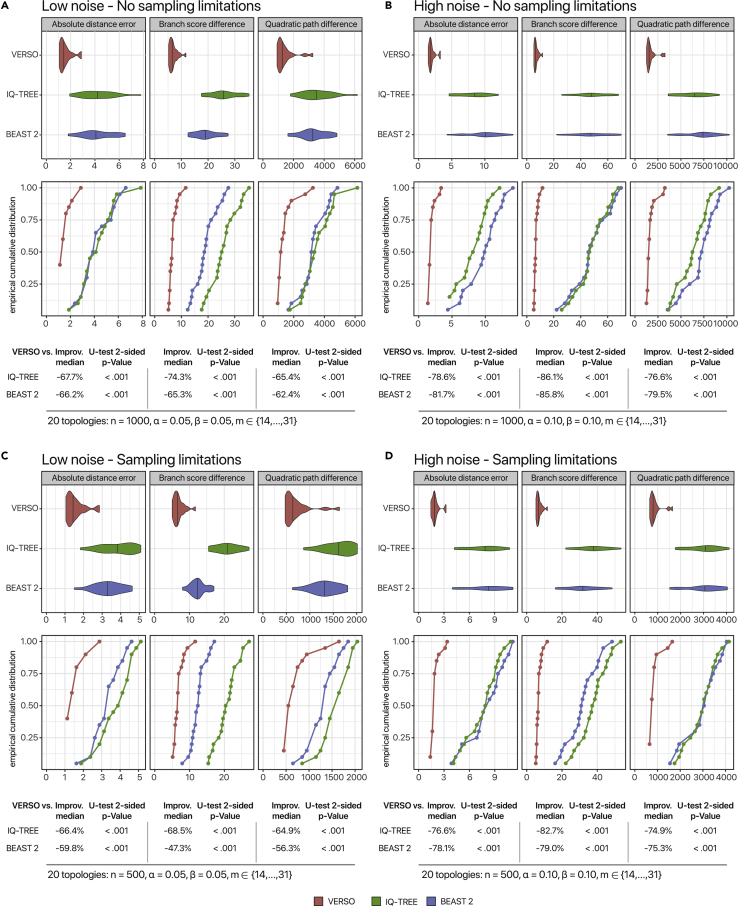
Comparative assessment on simulated data(A–D) Synthetic datasets were generated via the widely used coalescent model simulator msprime70 (see the Supplementary Material and Table S1 for the parameter settings). Twenty distinct topologies with 1,000 samples were generated, including a number of distinguishable variants in the range (14, 31). For each topology, four synthetic datasets were generated, with different sample sizes (n = 1000, 500), and different combinations of false-positives and false-negatives ([α = 0.05, β = 0.05], [α = 0.10, β = 0.10]), for a total of four configurations (A, B, C, and D) and 80 independent datasets. VERSO step #1 was compared with IQ-TREE10 and BEAST 2,22 on (1) absolute error evolutionary distance, (2) branch score difference73 and (3) quadratic path difference74 with respect to the ground-truth sample phylogeny provided by msprime (see the Supplemental experimental procedures for the description of the metrics). In the upper panels, distributions are shown as violin plots, whereas lower panels include the empirical cumulative distribution functions. The percentage improvement of VERSO with respect to competing methods is shown on all metrics (computed on median values), in addition to the p value of the two-sided Mann-Whitney U test on distributions, for all settings.